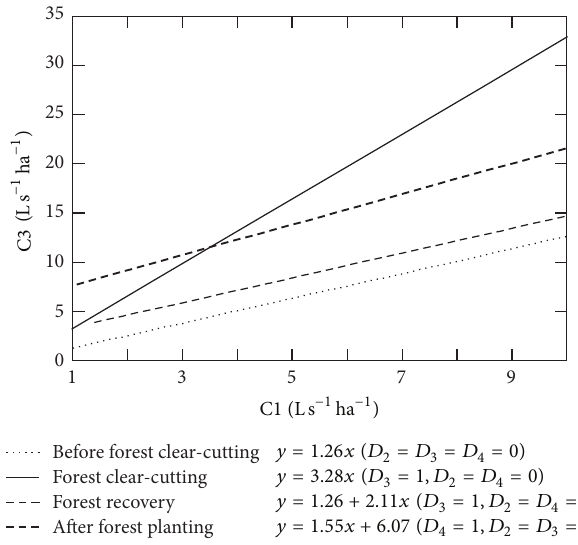
Figure 5: Multiple liner regressions analysis on peak discharge of 𝑄 𝑝 between treated catchment (C3) and control catchment (C1) after elimination of nonsignificant values in the analysis of dummy